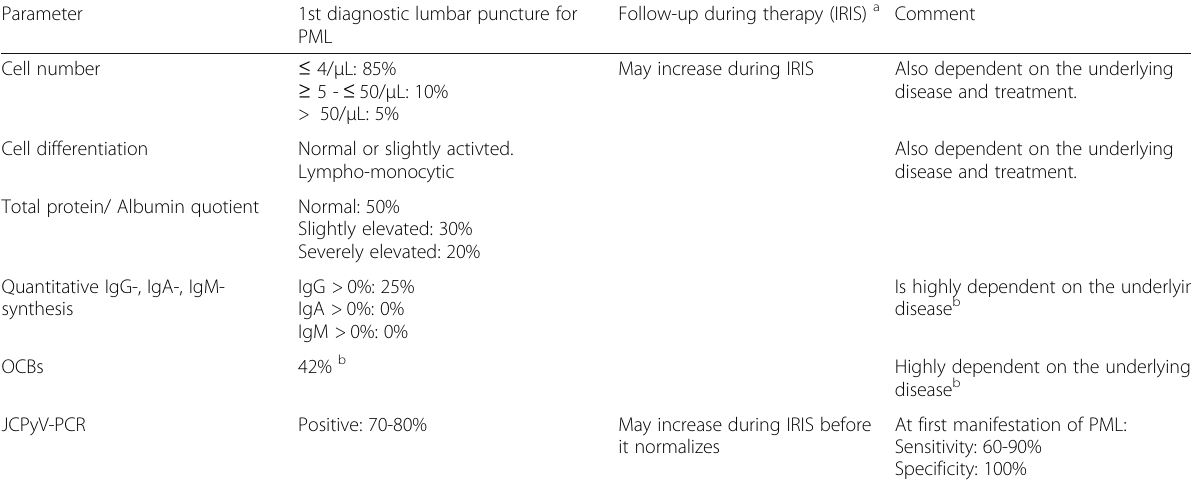
Table 10 Overview of routine CSF parameters and approximate frequency of pathological results in PML